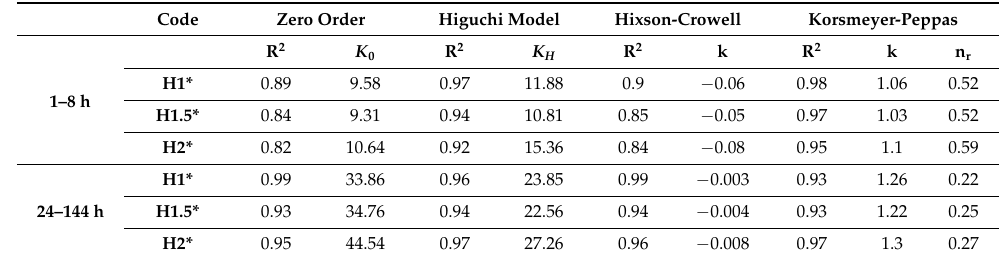
Table 2. The data resulted by fitting the experimental kinetic data for AmB on various mathematical models for the two stages (0–8 h) and (24–144